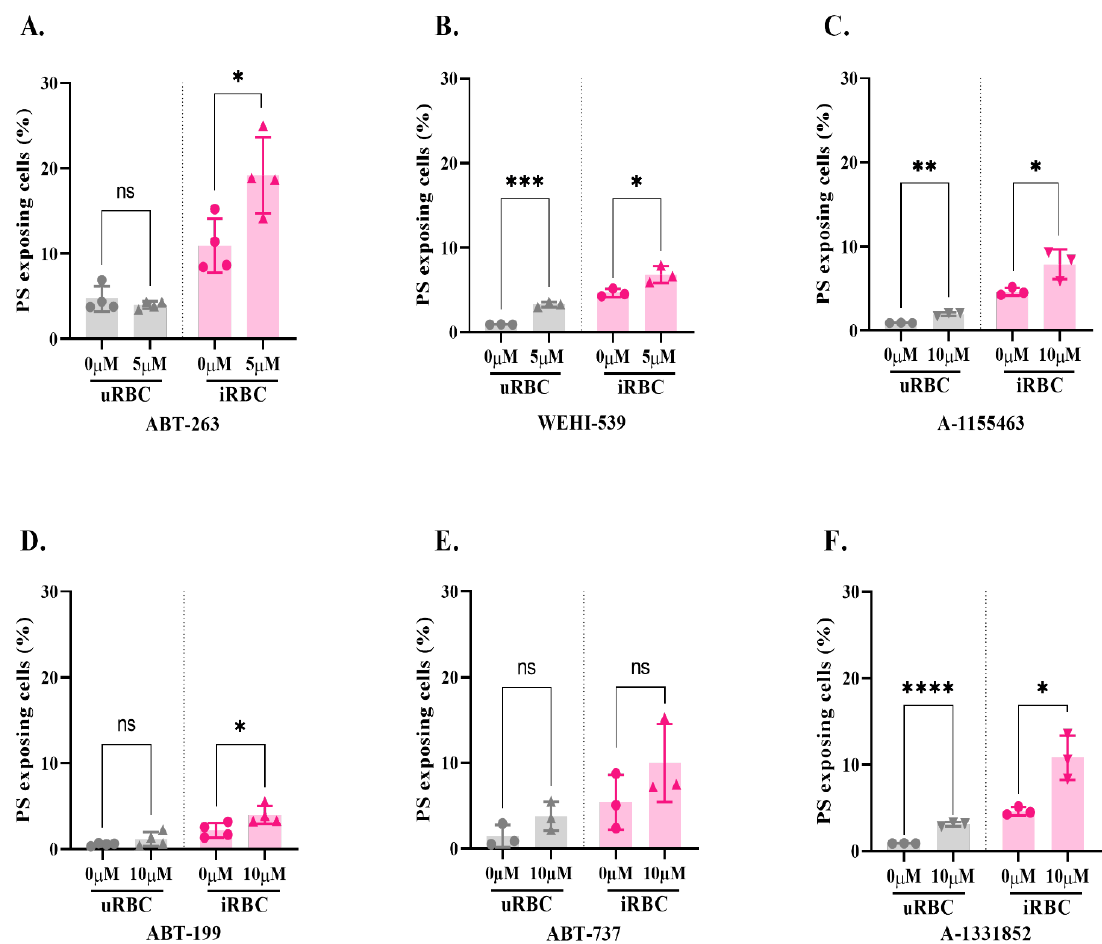
Figure 2. PS exposure of uRBCs and iRBCs exposed to BCL-x L inhibitors. ( A ) ABT-263. ( B ) WEHI-539. ( C ) A-1155463. ( D ) ABT-199. ( E ) ABT-737. ( F ) A-1331852. iRBC or uRBC cultures were exposed